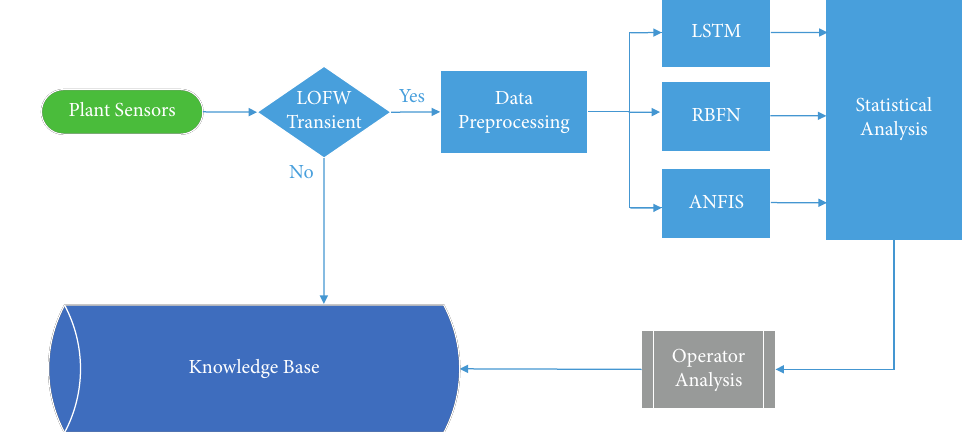
Figure 8: Proposed fault diagnosis Table 2: Performance indices of the ANFIS, LSTM, and RBFN models.